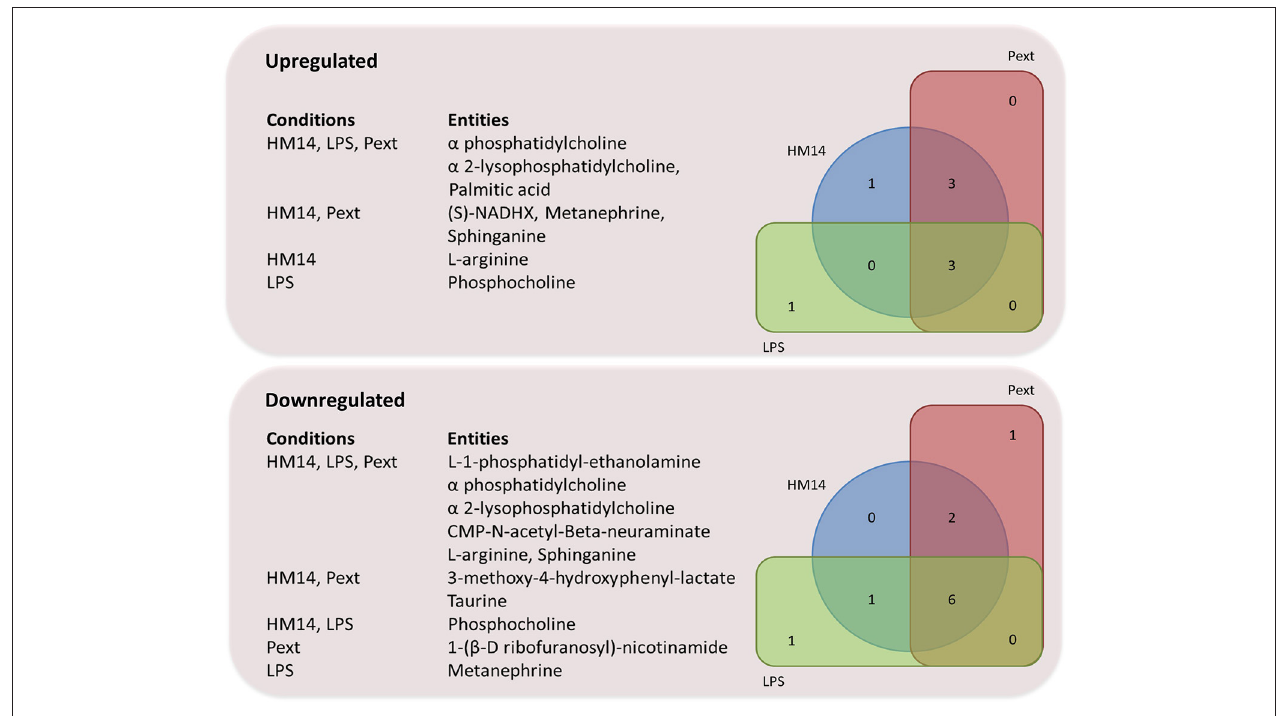
FIGURE 6 | Venn diagram representing over-and under-produced entities, referred to basal conditions, after MPP pathway